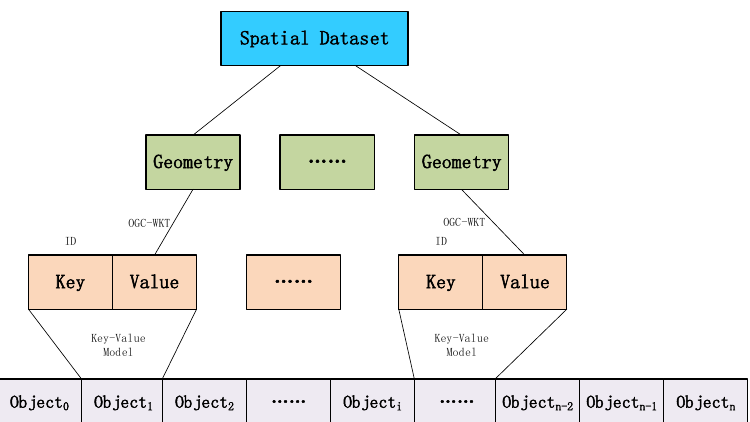
Figure 2. The spatial vector data cloud storage model, GeoCSV [18].